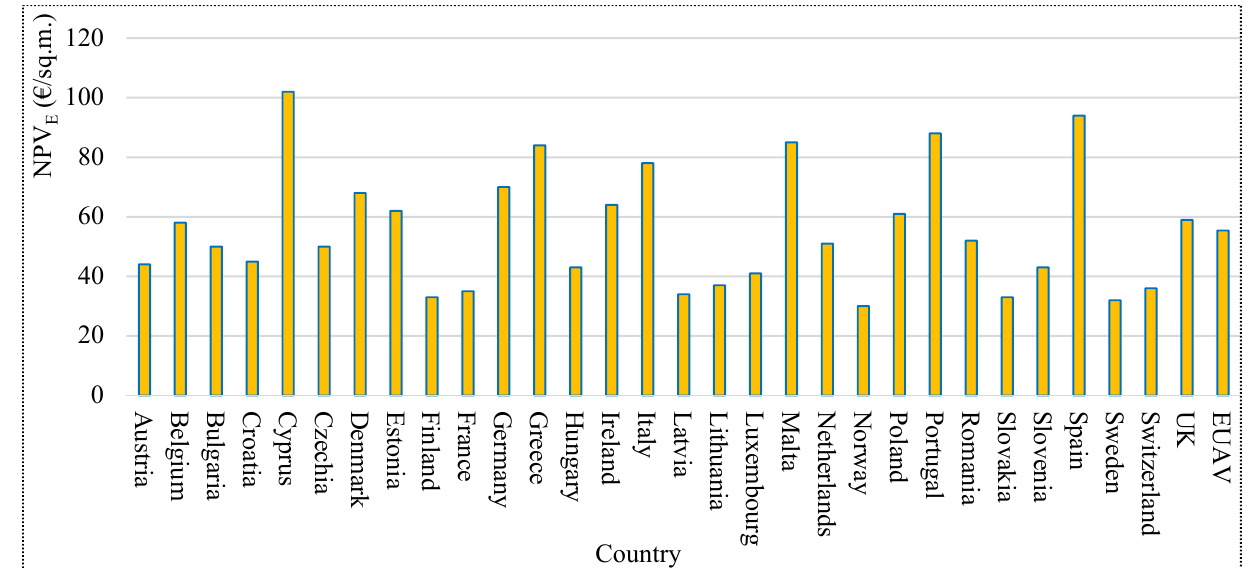
Figure 6. Levelised profit of environmental benefits (LPOE) of the BIPV system.